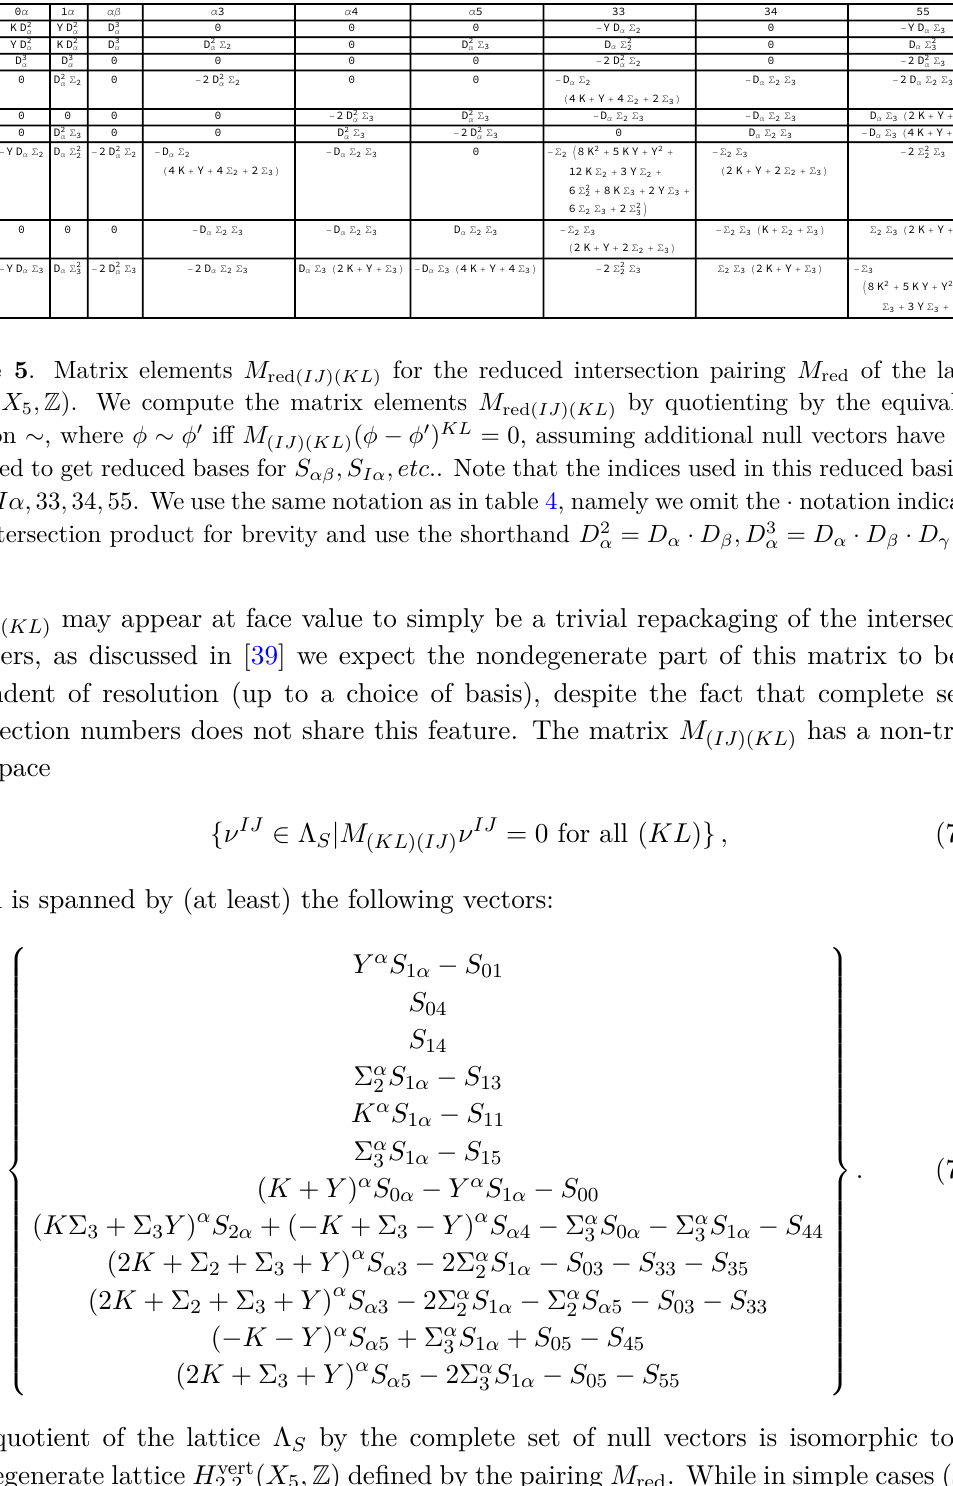
Table 5 . Matrix elements M